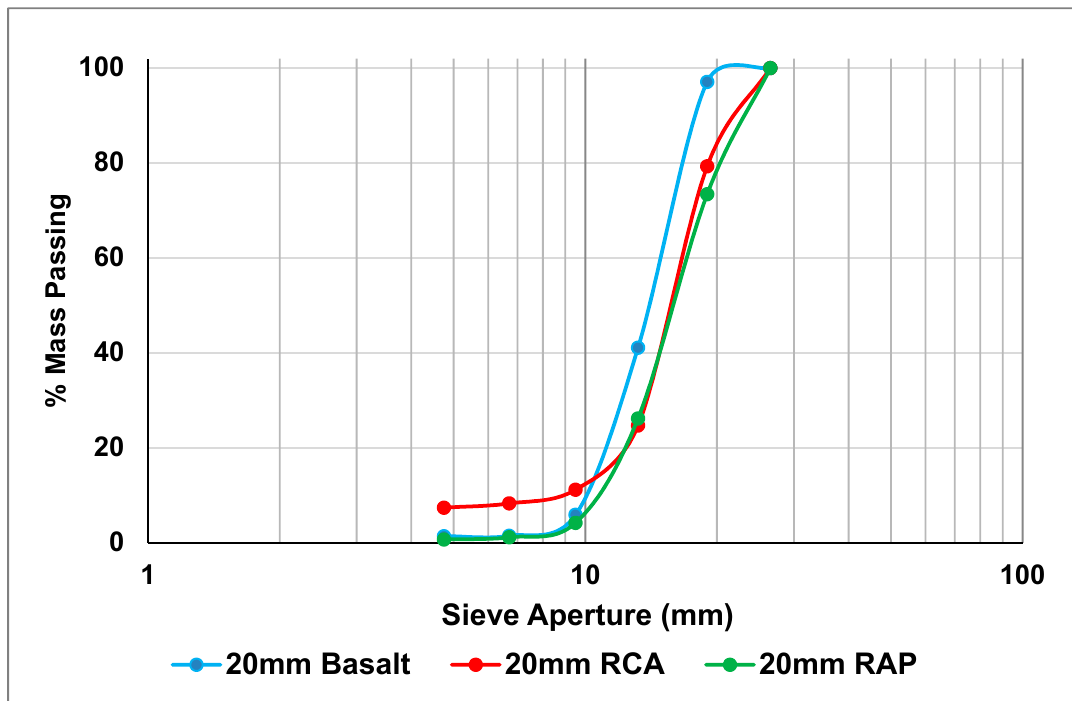
Figure 3. The Results of Particle Size Distribution Test for Coarse Aggregate; RCA: recycled construction aggregate; RAP: reclaimed asphalt pavement.